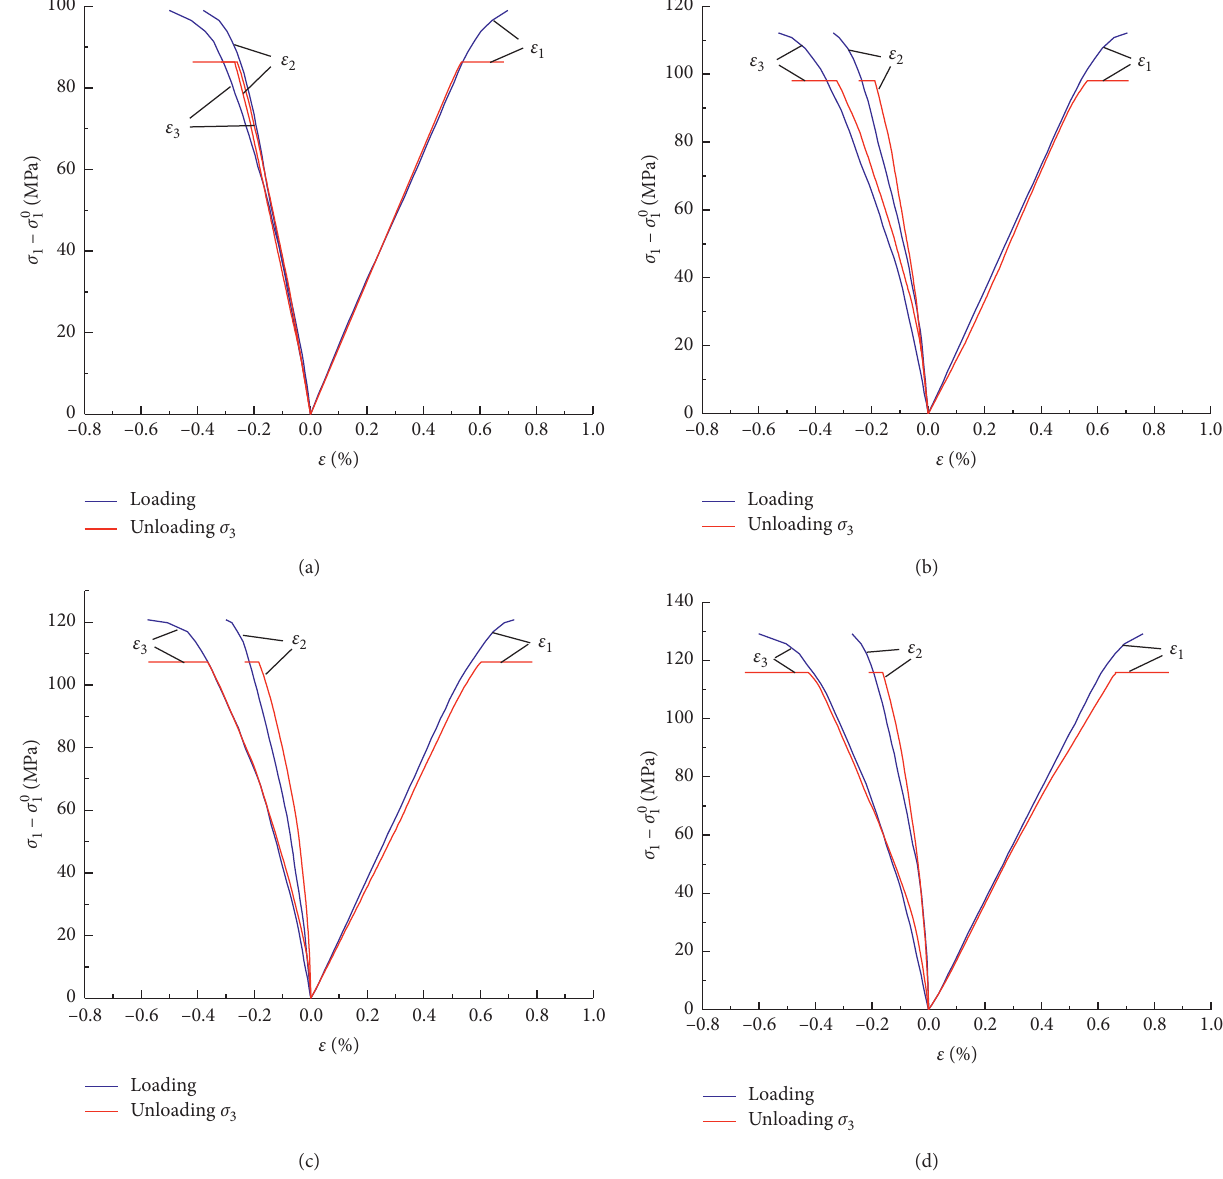
Figure 3: Loading and unloading stress-strain curves under different σ